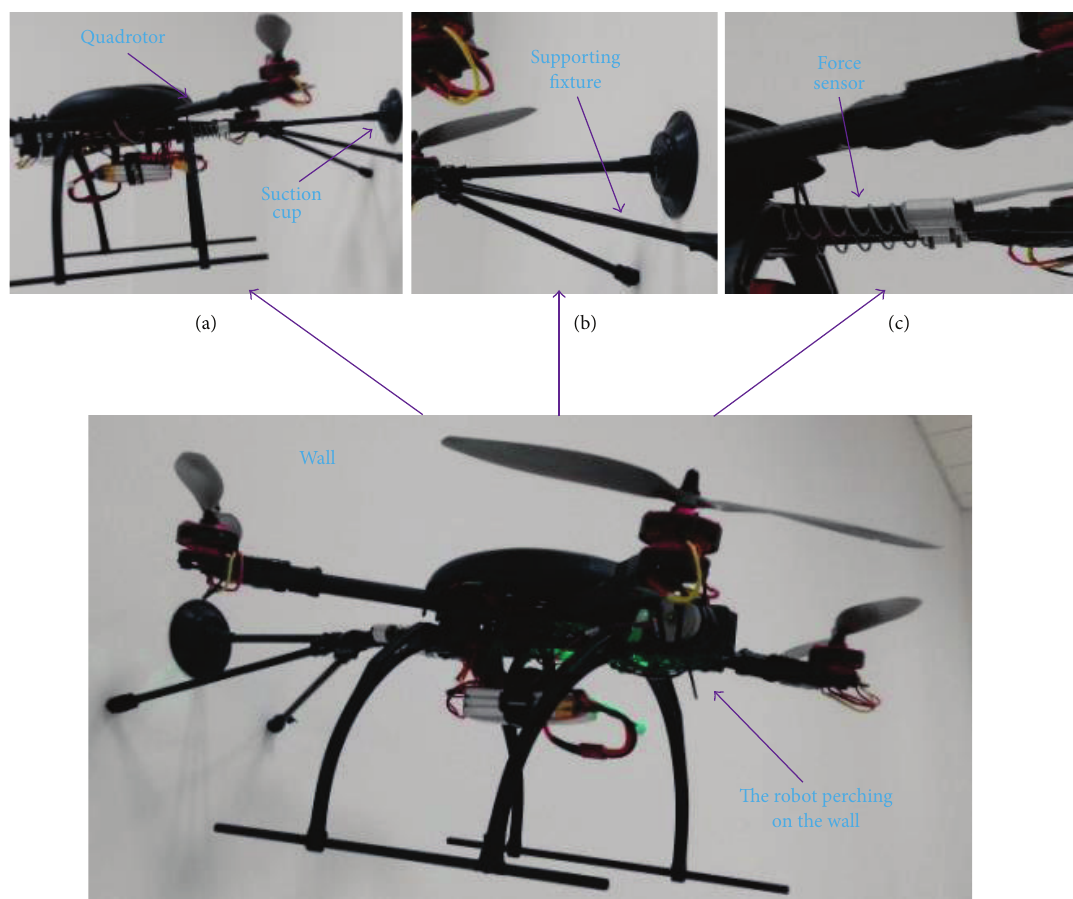
Figure 4: The prototype of the side perching robot. (a), (b), and (c) are views of local components of the robot showing the details when it rests on the wall. A suction cup seals with the wall which generates the vacuum chamber. The supporting system shown in (b) is well designed to provide more payload. A slider structure with spring and potentiometer is well designed to measure the external force.